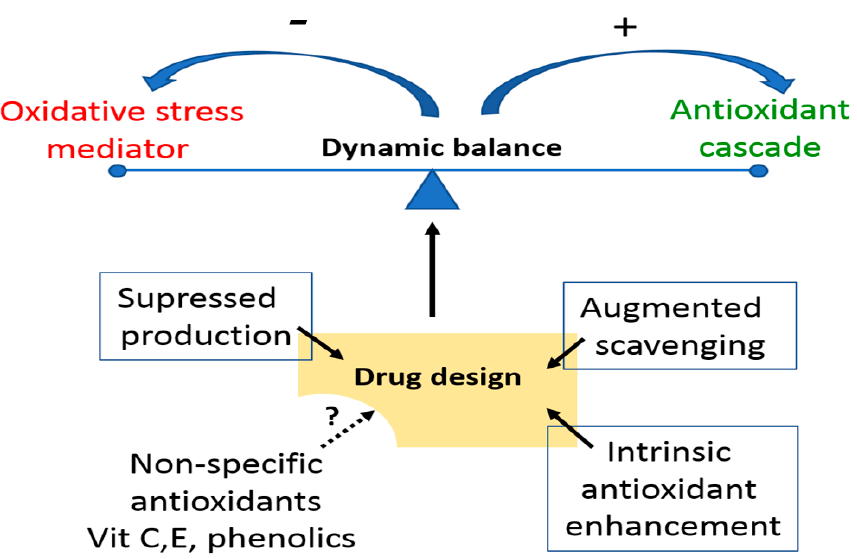
Figure 3. Options for targeted therapies to shift the prevailing oxidant status of a tissue through the balance of supply and loss. Low specificity dietary and other exogenous antioxidants have uncertain role in disease management beyond population level health benefits.